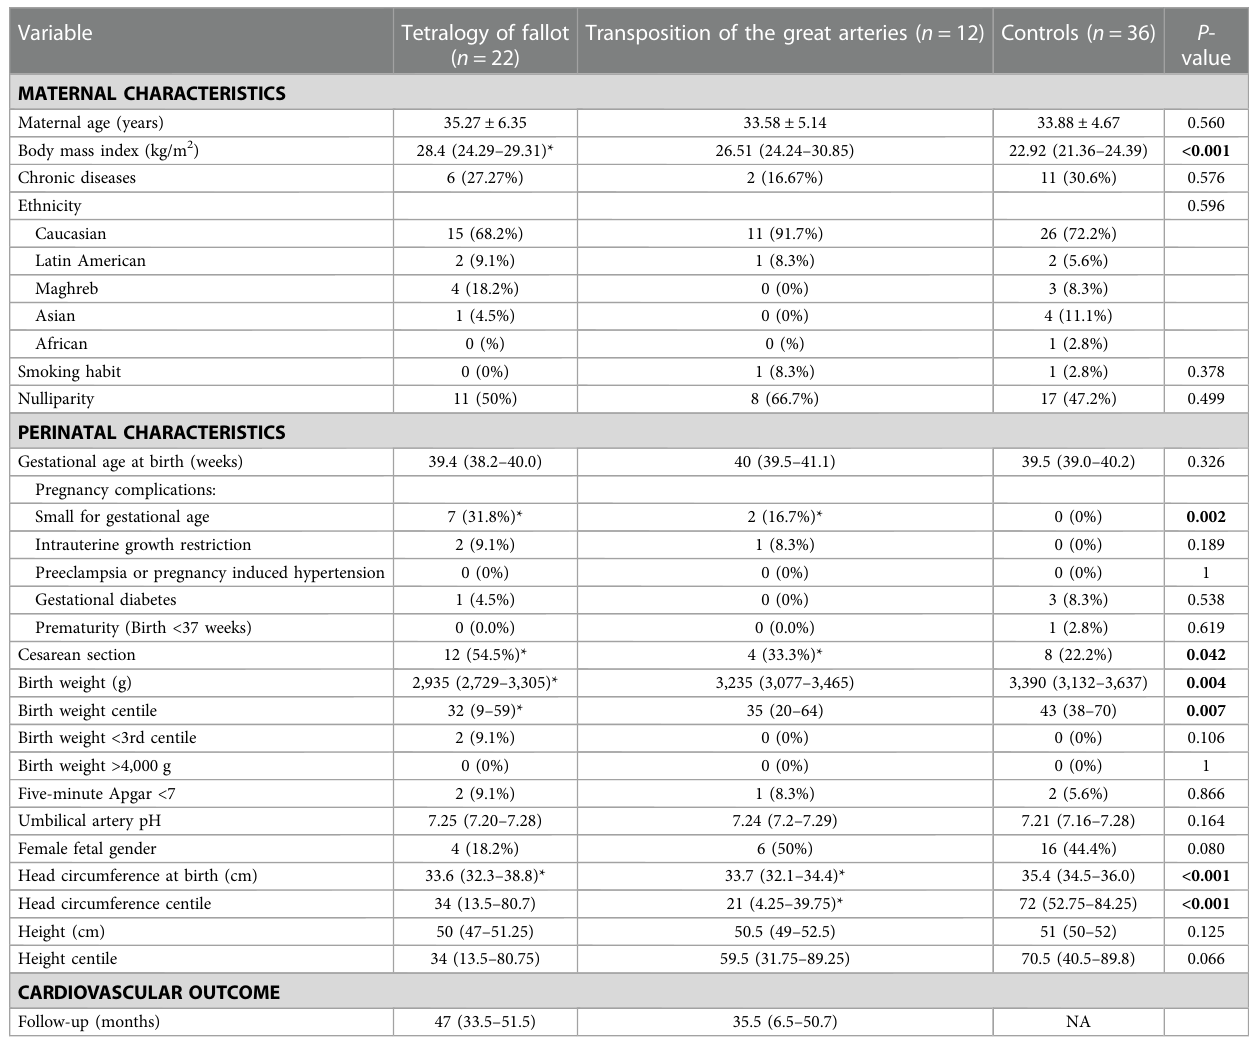
TABLE 1 Maternal characteristics and perinatal outcome in the study populations.